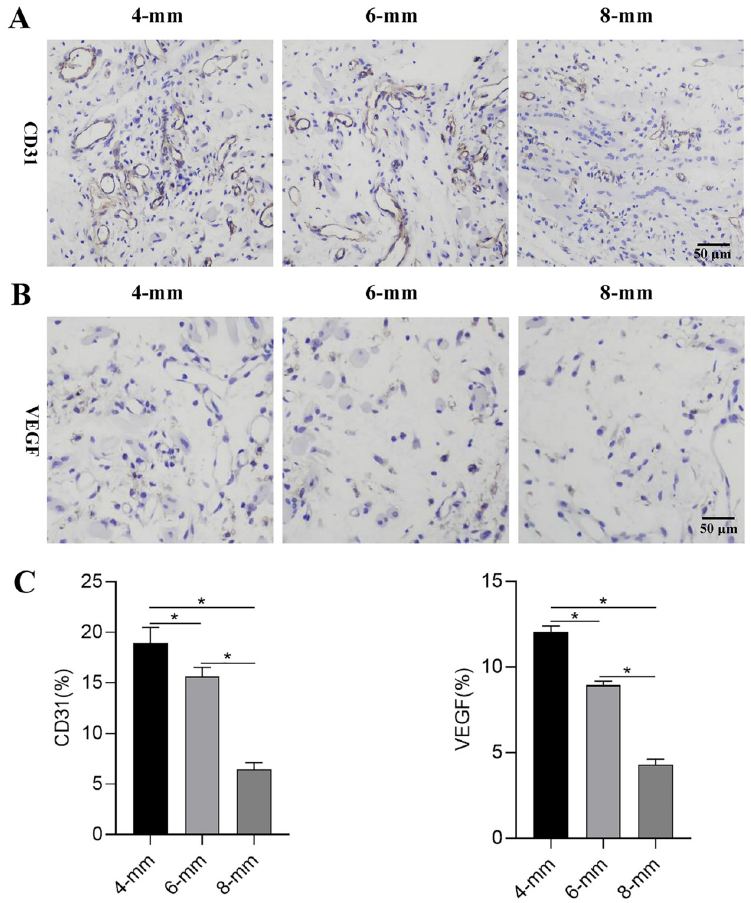
Fig 9. Immunohistochemical of CD31 and VEGF in the membrane tissues of 4-, 6- and 8-mm groups. (A)-(B) Representative images of immunohistochemical results of CD31 and VEGF and (C) quantitative analysis of the positive cells in the membrane tissues. ( � P <